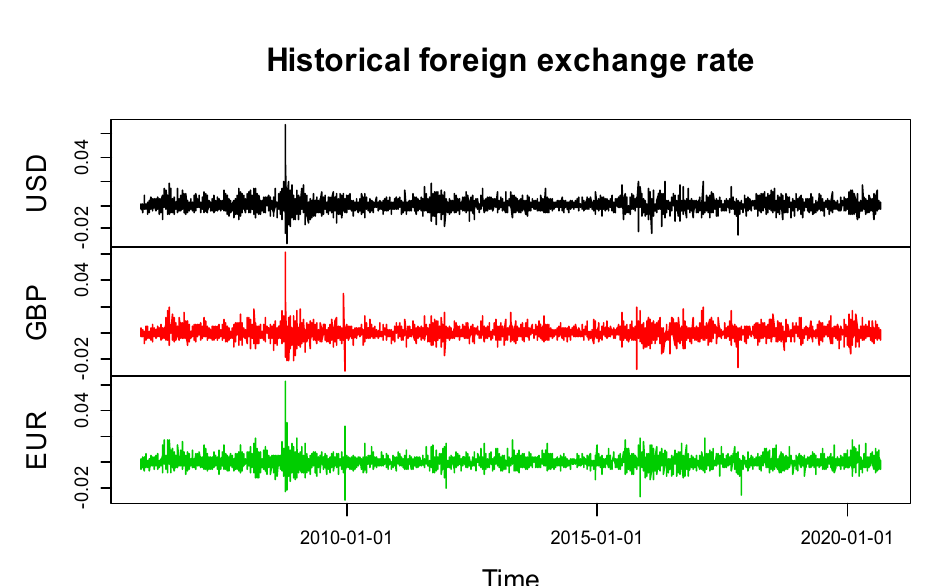
Figure A1. Daily historical exchange rate volatility. Note: Figure A1 shows the daily foreign exchange rate return before the COVID-19 pandemic for three currency pairs. USD is the US dollar exchange rate against the South African rand, GBP is the British pound against rand, and EUR is Euro against the rand.